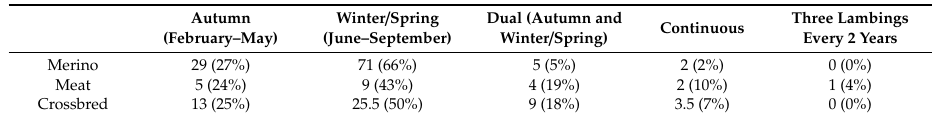
Table 1. Sheep producers ( n = 145) participating in a NSW survey in 2019 identified lambing time of ewes by breed.